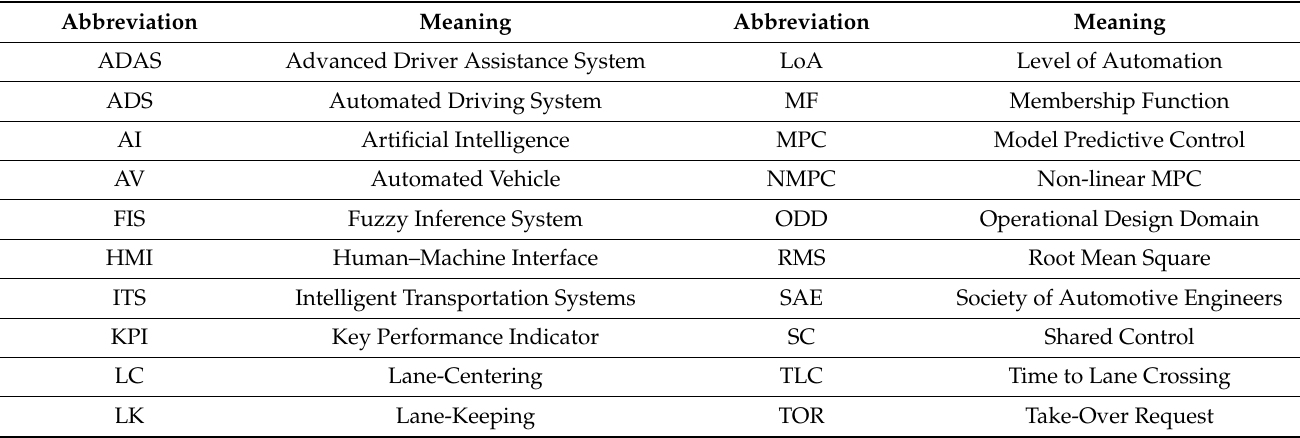
Table 1. List of